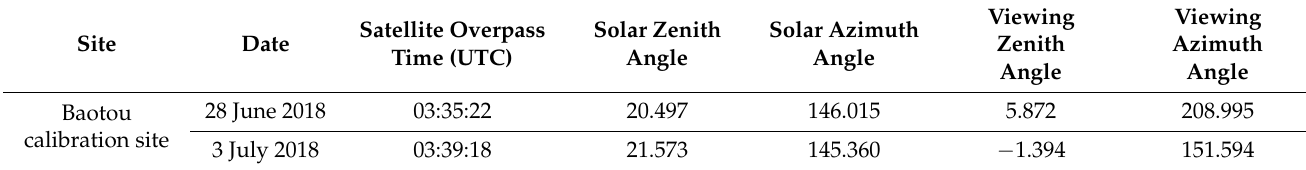
Table 2. Geometric conditions of the three ZY3-02 overpasses at Baotou calibration site in 2018.